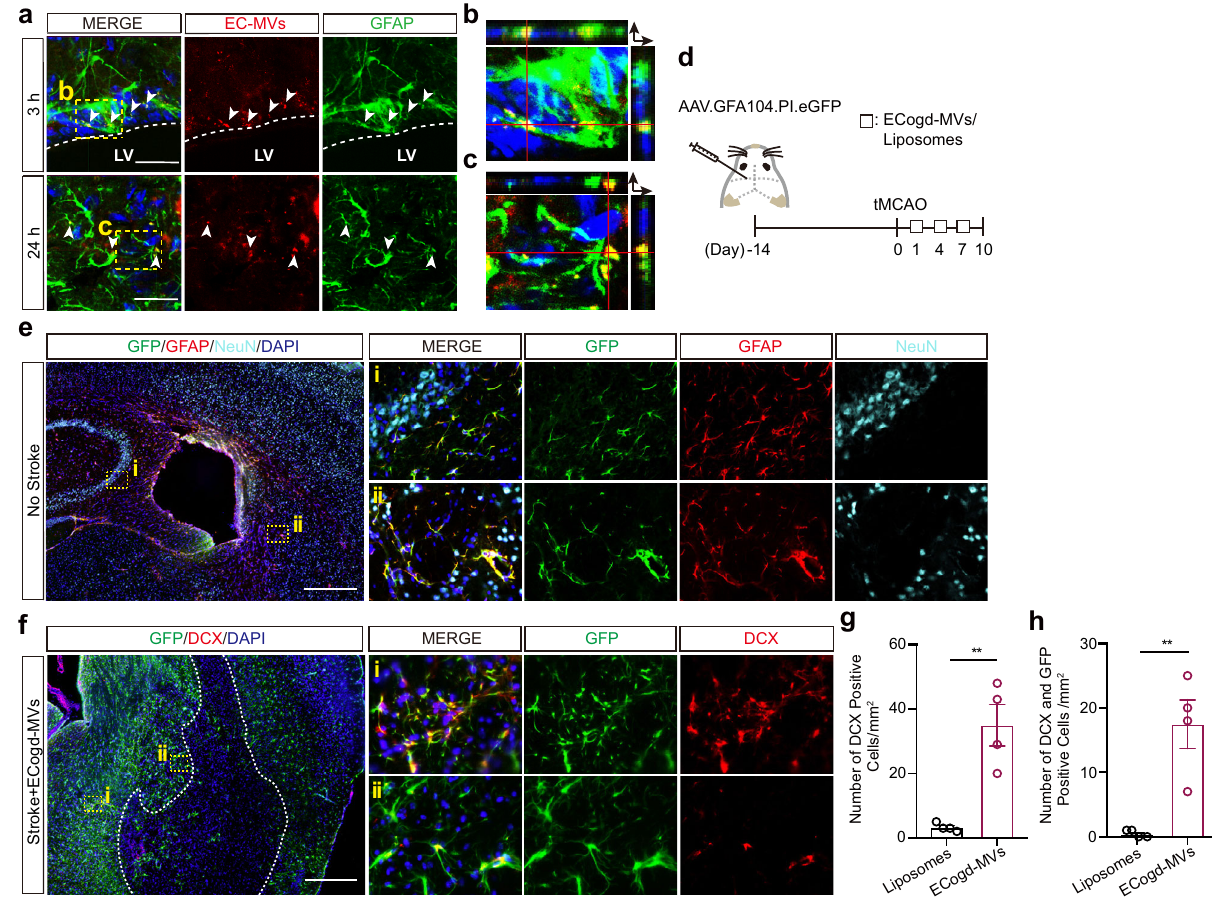
Fig. 5 | Microvesicles derived from OGD-stimulated brain endothelial cells convert astrocytes into neural progenitor cells in mouse focal cerebral ische- mia. Confocal microscopy revealed Cy3 labeled primary brain endothelial cells- derivedmicrovesicles(EC-MVs)couldbetakenintoastrocytesat3h( a , b )and24h ( a , c ) post lateral ventricle injection; Dashed white line indicates lateral ventricle border. d Experimental design. e Representative immunostaining of GFP, GFAP, and NeuN at day 14 post lateral ventricle injection of AAV.GFA104.PI.eGFP. f Representative immunostaining of GFP and DCX at day 10 post 45mins